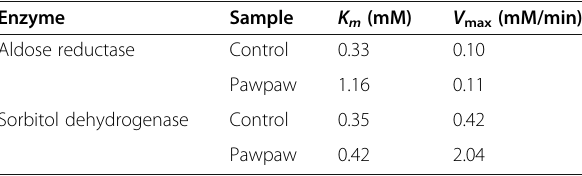
maximum velocity of